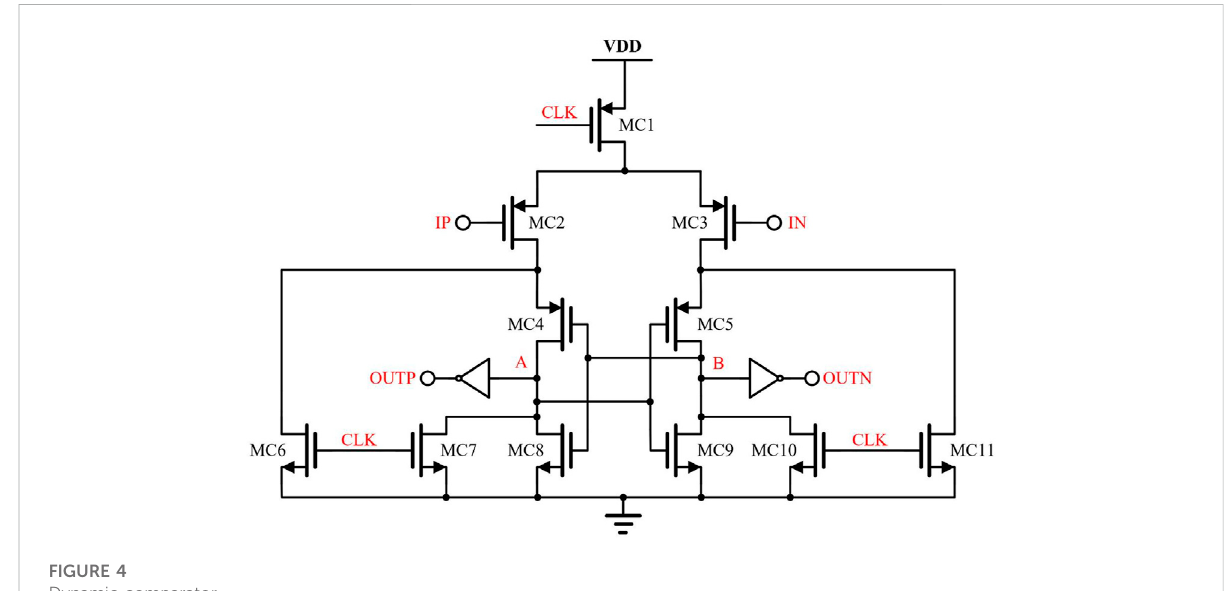
FIGURE 4 Dynamic comparator.